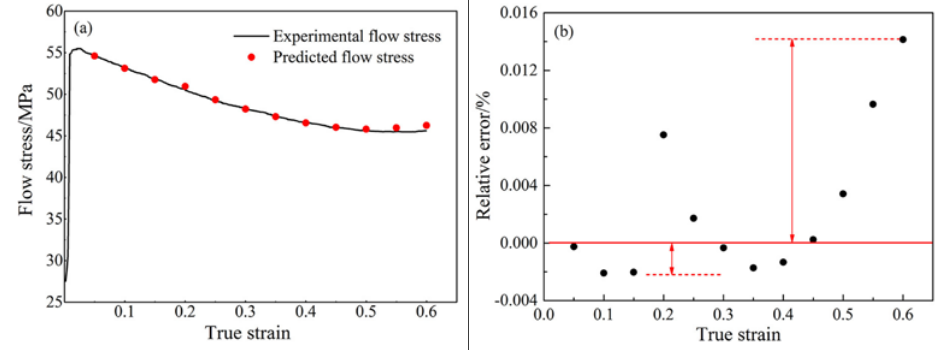
Figure 12. Relationship between predicted flow stress by the developed back-propagation (BP) neural network and experimental results at 743 K/0.1 s − 1 . network and experimental results at 743 K/0.1 s − 1